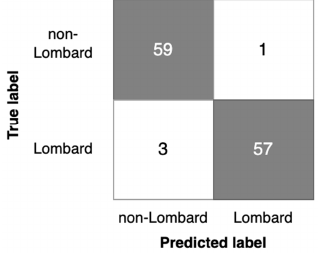
Figure 9. Confusion matrix for the G2 model. Sensors 2023 , 23 , x FOR PEER REVIEW